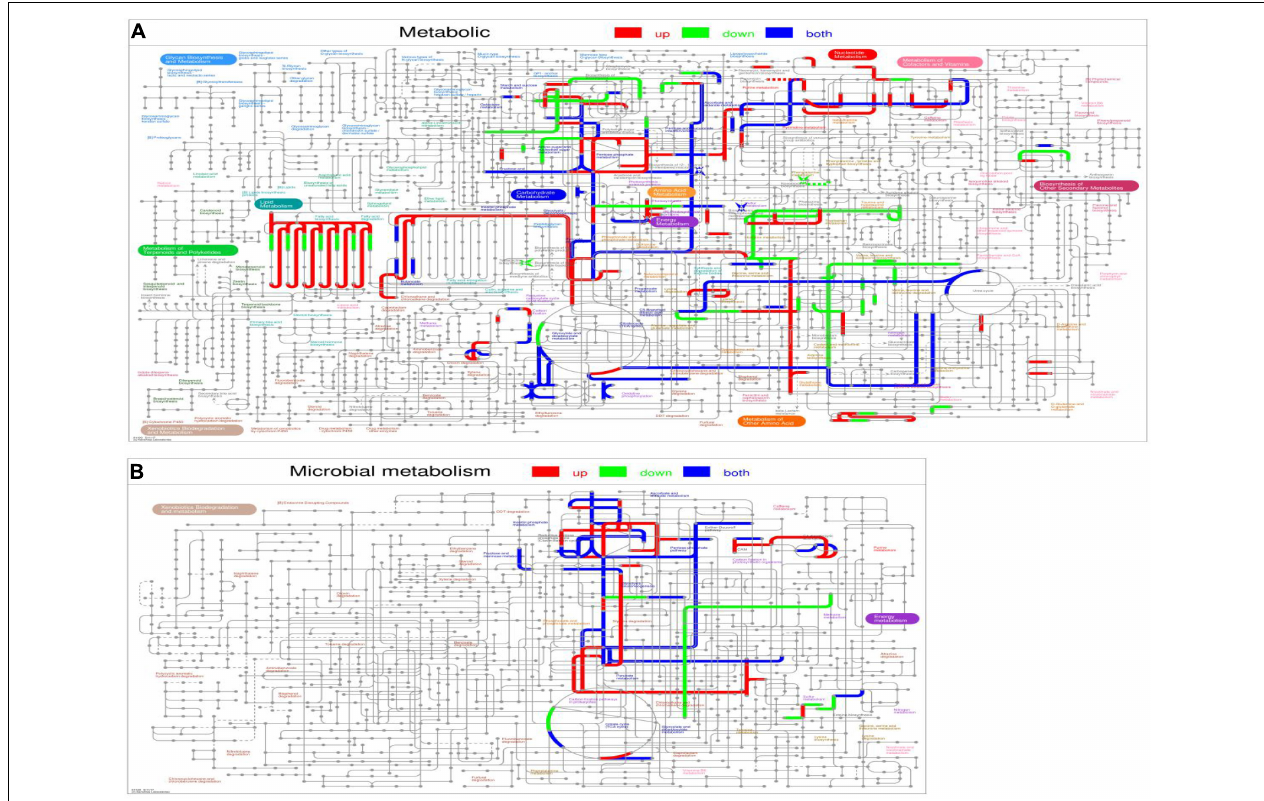
FIGURE 6 | Interactive Pathways Explorer (iPath) analysis. (A) Metabolic. (B) Microbial metabolism. Red lines show up-regulated pathways, green lines show down-regulated pathways, and blue lines show both up-regulated and down-regulated pathways.